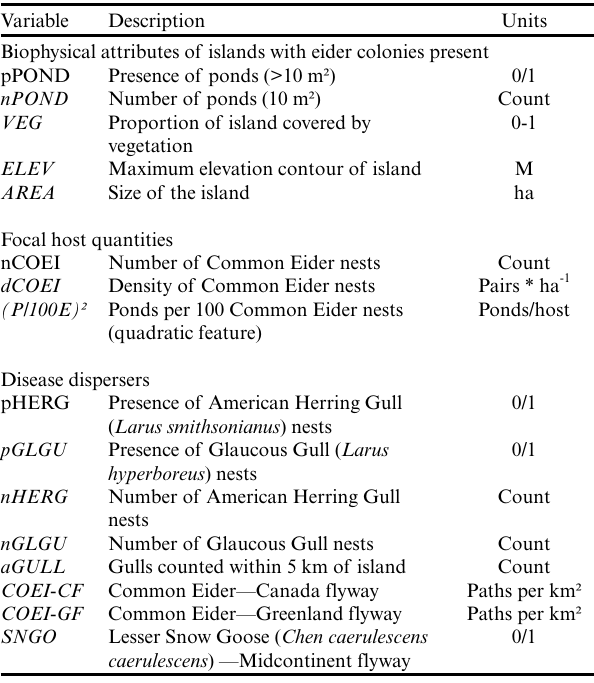
Table 1 . Variables examined to identify ecological predictors of Avian Cholera outbreak probability at Common Eider ( Somateria mollissima ) breeding